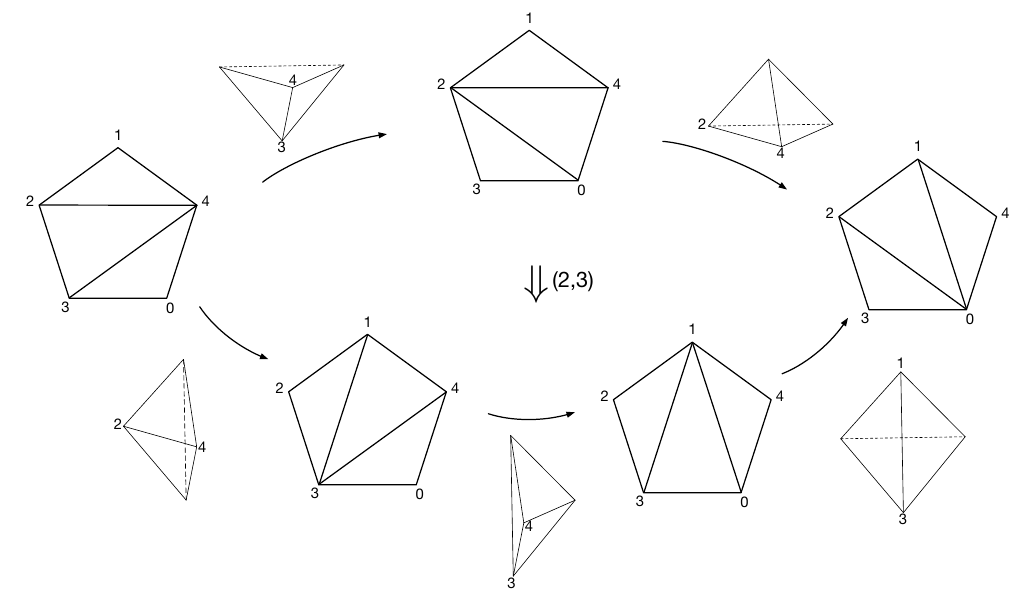
Figure 2 . The (2,3) Pachner move, interpreted as relating two different sequences of flips. (Thus ( ∂ ∆ 5 ) omits vertices 0, 2, and 4; while ( ∂ ∆ 5 ) + omits vertices 1, 3, and 5.) Note − are triangulations of the same 4d polyhedron, homeomorphic to a standard that ( ∂ ∆ 5 ) ± 4-disc D 4 , which plays a role analogous to the bipyramid